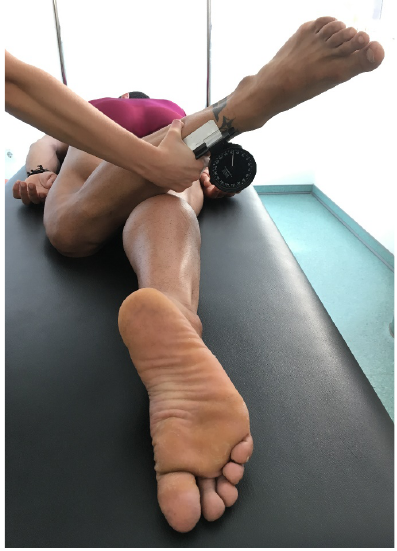
Figure 2. Subject in prone and axis of Pluritor C aligned with margo anterior tibiae to measure rotation of the hip (figure with kind permission of Thieme group, ©Thieme).